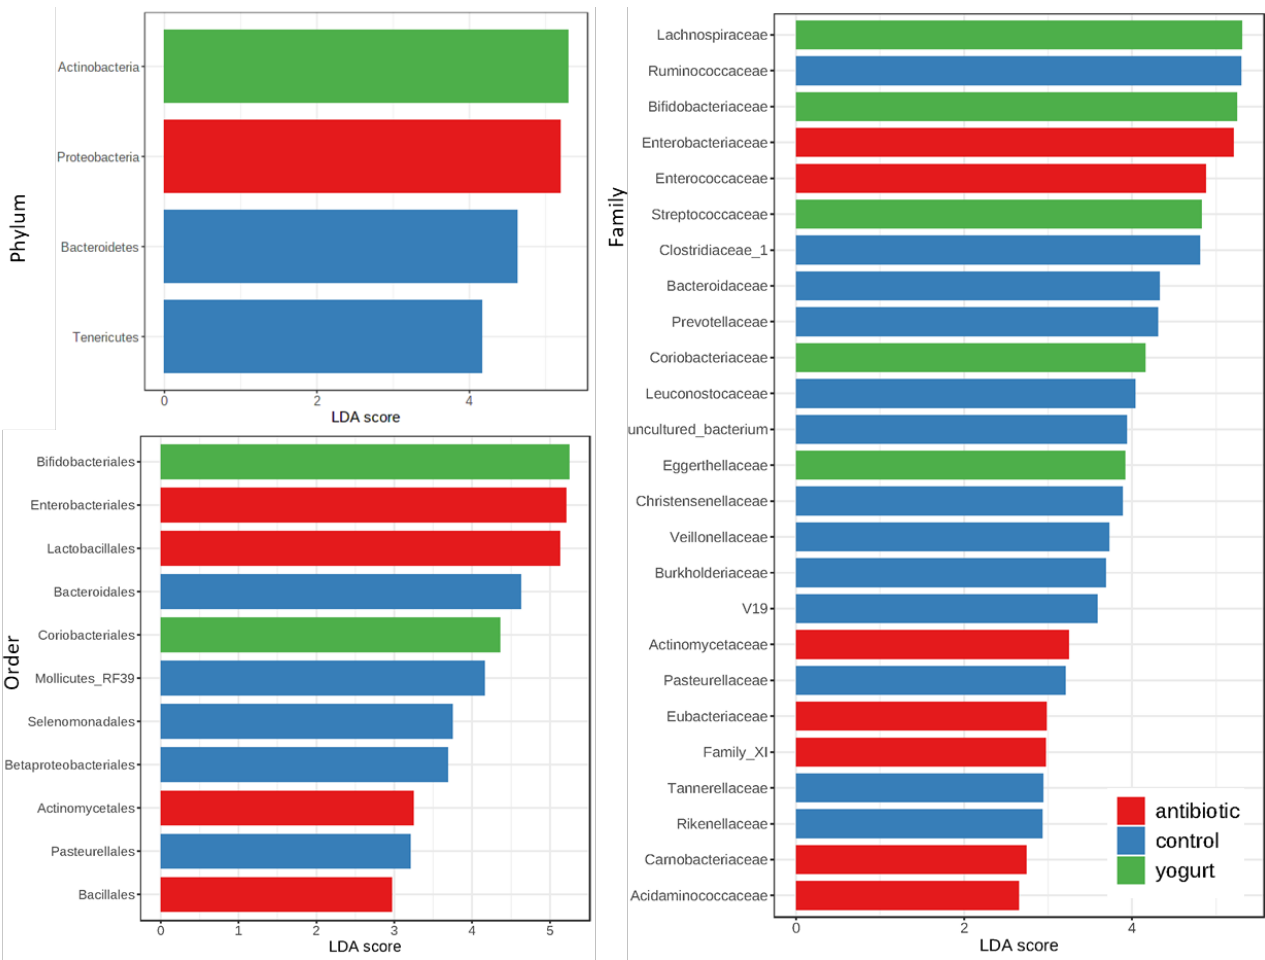
5 of 9 Figure 2. Alpha and Beta Diversity of the Gut Microbiome. ( A ) Alpha diversity evaluation at Chao1, Shannon, Simpson and observed indexes; ( B ) Beta diversity based on the PERMANOVA statistic method.